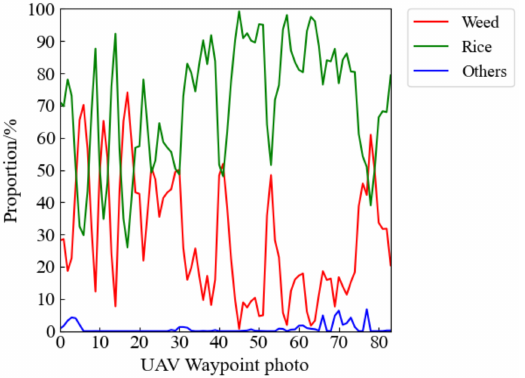
Figure 12. Proportion of pixels of different categories in the prediction results.